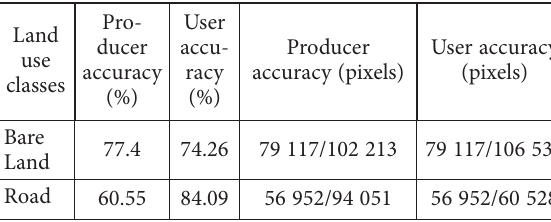
Table 4. Maximum likelihood accuracy assessment